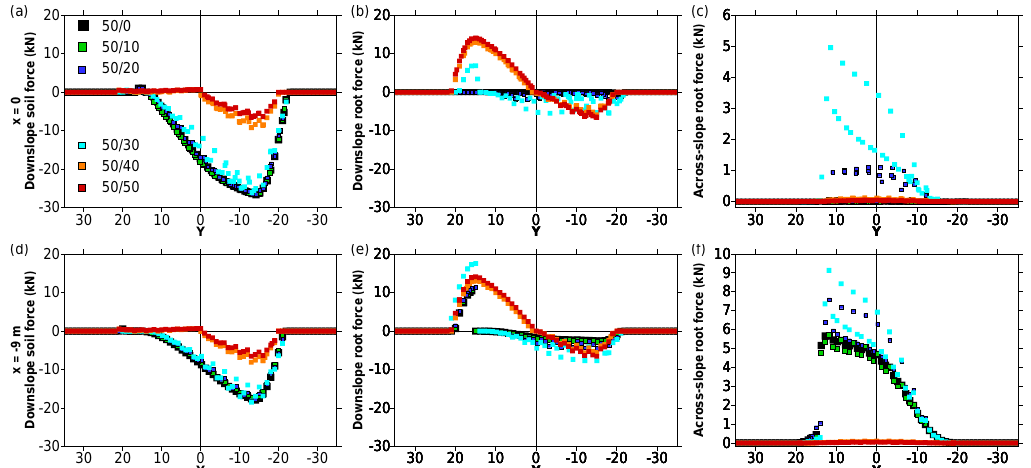
Figure 15. Effects of clearing tree size on (a, d) downslope soil force, (b, e) downslope root force, and (c, f) across-slope root force along two downslope sections at (a–c) x = 0 and (d–f) x = − 9m near the clearing–stand transition just before failure (simulations 50/0, 50/10, 50/20, and 50/30) and at the end of the simulations (50/40 and